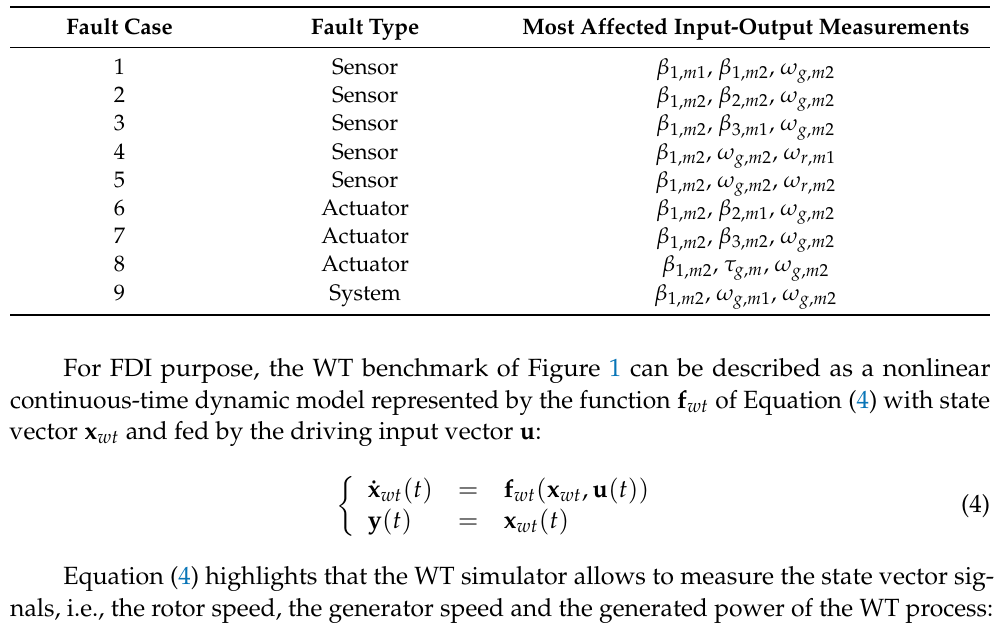
Table 3. Fault scenario of the WT